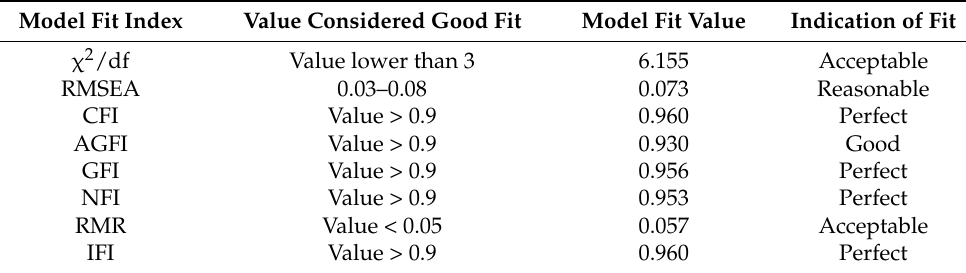
Figure 1. CFA Output for SIIEFSSI, as explained in Table 3. Table 4. CFA model: Goodness-of-fit statistics.